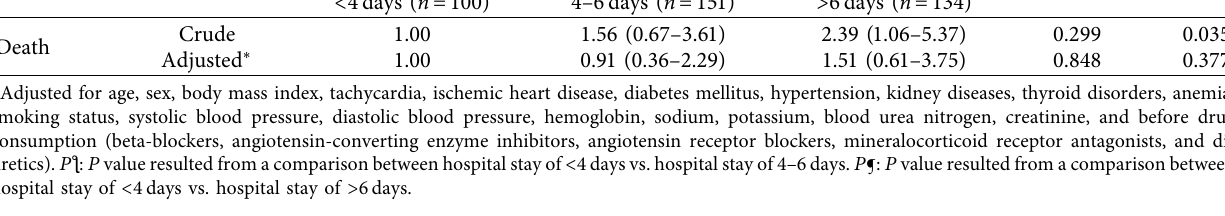
Table 5: Length of hospital stay, neutrophil to lymphocyte ratio (NLR), platelets to lymphocyte ratio (PLR), modifed shock index (MSI), rehospitalization and death during 30-days follow-up divided by the EF groups. ∗ signifcant between group diference.